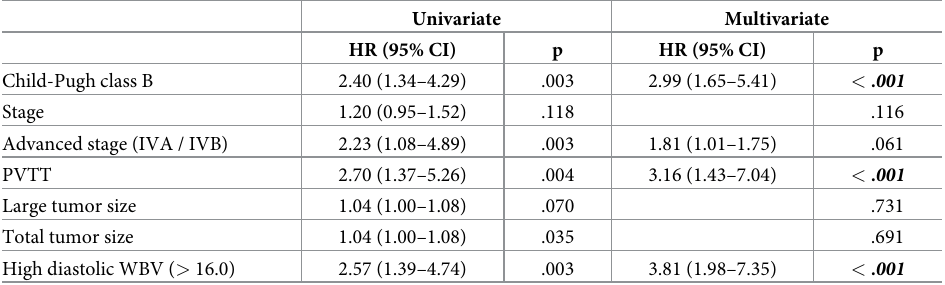
Table 4. Univariate and multivariate Cox regression analysis for factors associated with the overall